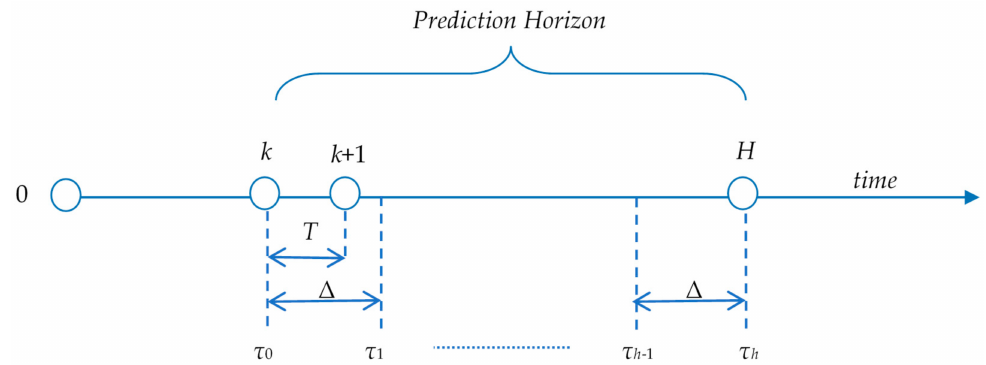
Figure 2. The new prediction horizon’s discretization versus the discretization involved in the sampling